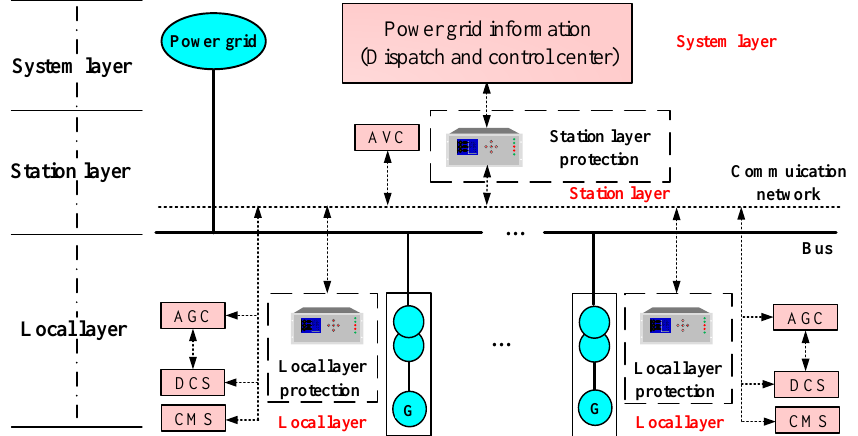
Figure 1. Structure diagram of the multi-information fusion-based hierarchical power generation-side protection